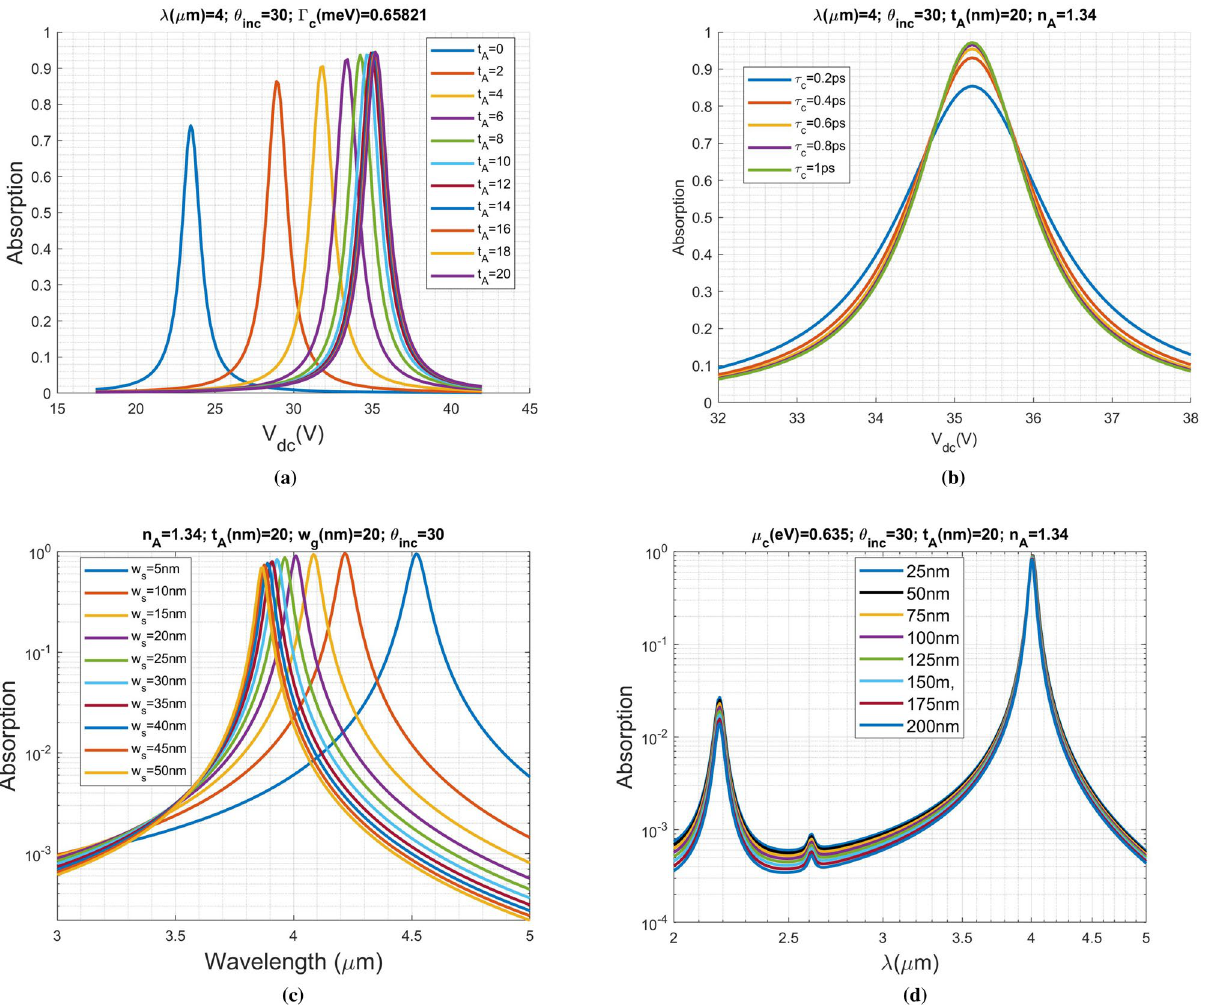
Figure 5. Parametric studies for the biosensor with typical structure dimensions including silica thickness, analyte thickness and slit width are 50 nm, 20 nm and 20 nm, respectively. The chemical potential and carrier relaxation time are 0.635 eV and 0.5 ps, respectively. The RI of analyte is n A = 1.34 . ( a ) Variation of SPR curve (absorption efficiency of the graphene ribbons array) against gate voltage for various analyte thickness. ( b ) Variation of SPR curve against gate voltage for various carrier relaxation time ( τ c ). ( c ) Resonant absorption spectra for various slit widths and ( d ) Variation of SPR curve against wavelength for various silica The chemical potential and carrier relaxation time are µ c = 0.635 eV and τ c = 0.5 ps, respectively. The analyte RI and thickness are n A = 1.34 and t A = 20 nm. Notably, only the fundamental mode of SPR was shown in this figure. The SPR is due to the resonant of SPPs along the ribbon-width direction and depends on the ribbon width 50 ; however, it is apparent to see that the resonant wavelength is varying in accordance with the change in the slit width. Additionally, the line width of SPR curve is getting wide when the slit width is decreasing. This may be explained as the occurrence of strong mutual coupling between two adjacent ribbons for the case of narrow slit width. Moreover, the coupling is caused by the leakage in resonator 10 , reducing the quality factor (increase in line width) of SPR curve. Contrarily, the SPR curves gradually converges for w s greater than 40 nm; the graphene ribbons can thus be regarded as isolated ones with negligible coupling. In Fig. 5d, we change the silica thickness to see the variation on absorption spectra. The resonant coupling to the graphene ribbons array is due to the evanescent wave in the silica. Moreover, the attenuation constants of − ε SiO ε Si sin θ 2 evanescent wave in silica can be determined by α z = k o , which is about 0.00154 nm − 1 at inc 2 (cid:31) (cid:31) = 4 µ m and is around 0.0028nm − 1 at (cid:31) = 2.2 µ m. For the silica thickness much smaller than a wavelength, the change in the impinging field on the graphene nanoribbons is insignificant at (cid:31) = 4 µ m , while is distinguish- able at (cid:31) = 2.2 µ m, depicted in this figure.